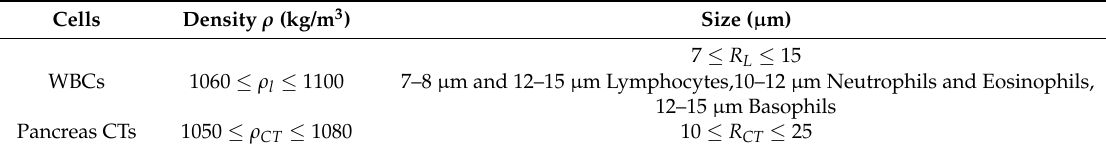
Table 1. Range of variability assumed for the size and density of WBCs and